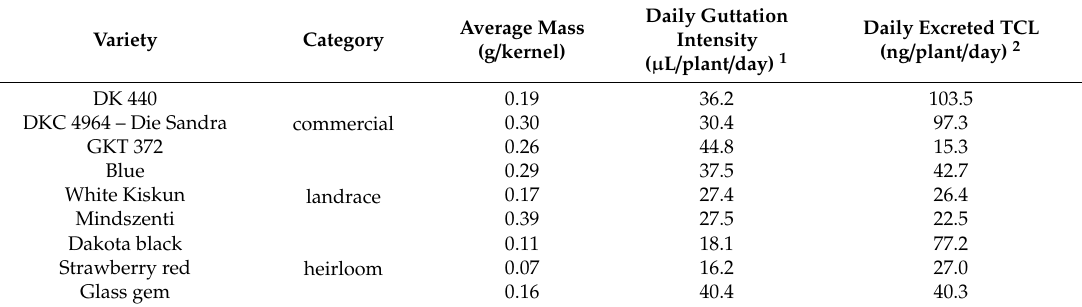
Table 1. Maize seeds used for comparison of varieties.